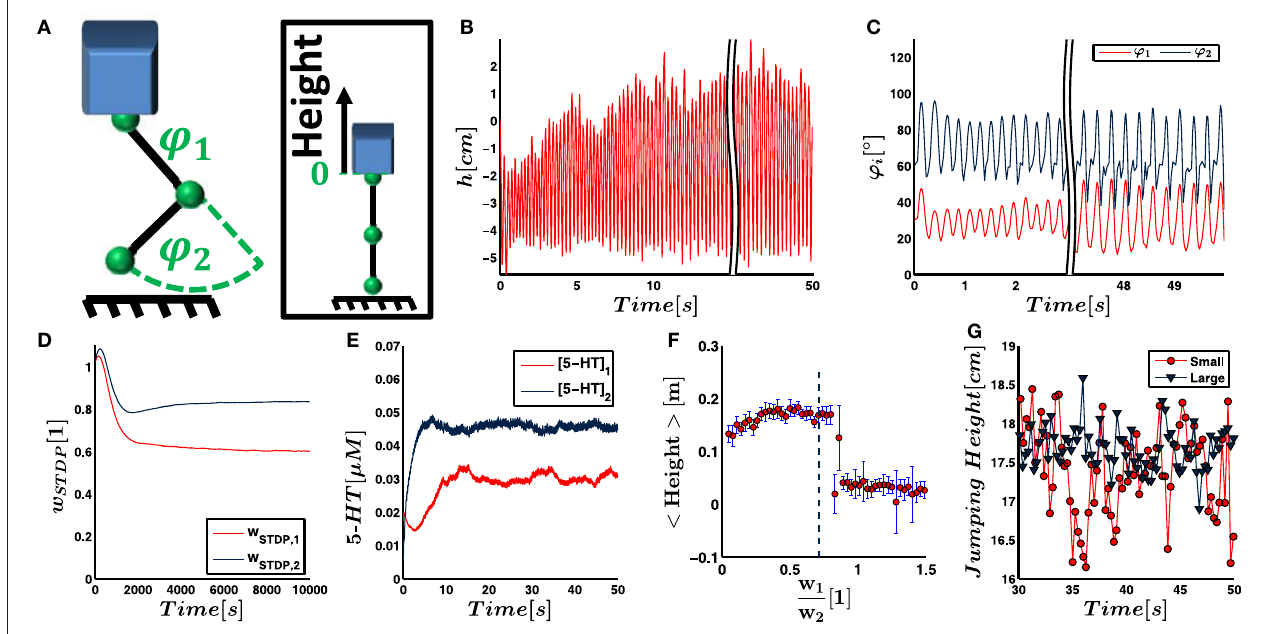
FIGURE 6 | (A) In the final simulation, the neural network as described in Figure 4 is designed to control a more biologically realistic trunk model that has a jumping leg with two joints influenced by gravity. The neural network gets sensory input about joint deflections and controls the torque within these joints. The jump height is taken as indicator for energy efficiency. It is measured as height of the trunk relative to its position when both joints are fully extended. (B) The jump height of the leg increases as a result of the weight adjustment by the neural network. (C) The joint deflections are linearly converted to firing rates of the sensory neurons and therefore also represent the sensory input to the neural network. (D) The synaptic weights from proprioceptors innervating muscles of joint 1 and 2 to the pool of postsynaptic LIF neuron converge on a time scale of hours. (E) Neuromodulatory weights are proportional to the serotonin concentration. They converge faster than the synaptic weights, and the serotonergic concentration within the two motoneuron pools starts to fluctuate around its final value after seconds. (F) To find conditions for energy efficiency of the controller numerically, we fix the Euclidean norm of the weight vectors describing the synaptic input and neuromodulatory output weights. We vary the ratio w 1 / w 2 both for input and output weights, run a separate simulation for each ratio and record the respective jump height. As illustrated, the jump height has a maximum plateau for ratios between 0.4 and 0.75 . This ratio is in agreement with the weight ratios obtained by STDP and serotonin dynamics. (G) Even after convergence, the jump height, illustrated as maximum height above the ground here, shows fluctuations with time. We suggest that this is due to noise and the small number of leaky integrate-and-fire neurons that is intrinsic to the controller network. Accordingly, increasing the network size from small to large significantly decreases the fluctuations. (All results illustrate the simulation with non-random initial